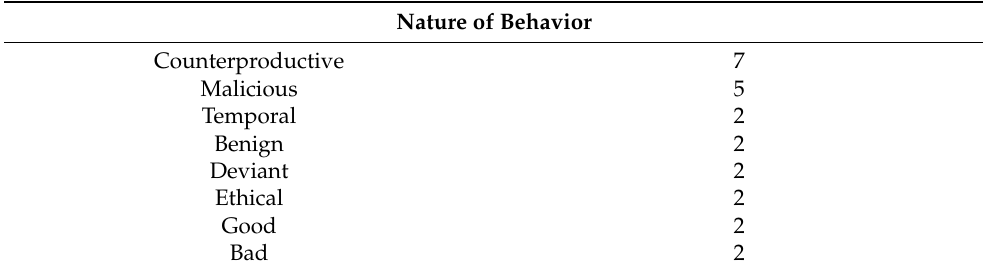
Table 6. Frequency and categories of topic terms in the study of the behavioral nature of the relationship between leadership and